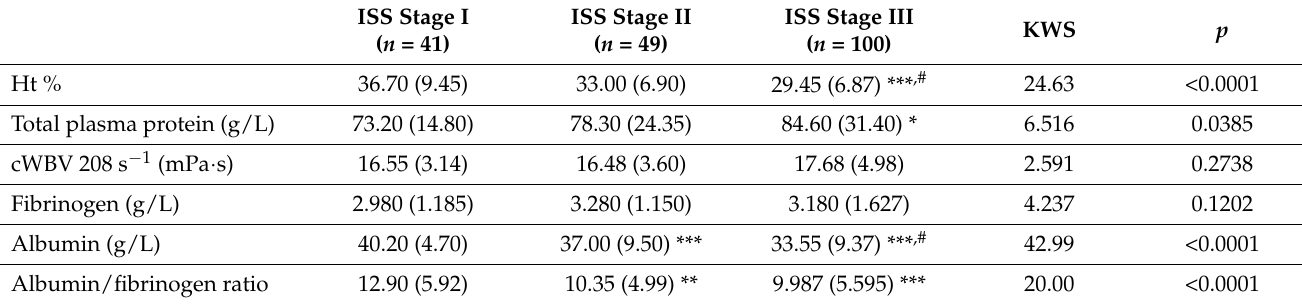
Table 4. Medians (IQRs) of hemorheological determinants in MM patients subdivided according to ISS.